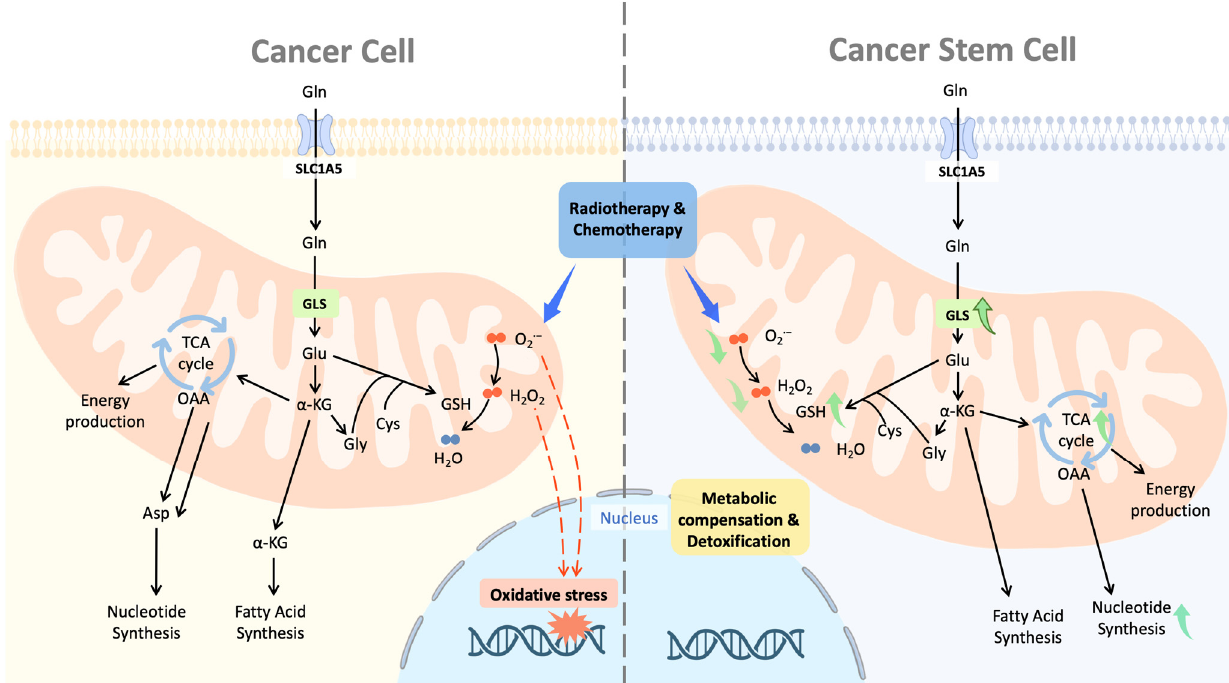
Figure 1. The metabolic compensation of CSCs. CSCs exhibit enhanced glutaminolysis as a result of the overexpression of glutaminase and the consumption of glutamine. This trait contributes to the metabolic compensation for chemotherapy by promoting the production of glutathione to scavenge free radicals and nucleotide biosynthesis to repair DNA damage. Both of these processes are necessary to compensate for the damage caused by chemotherapy. Additionally, glutathione has the ability to neutralize platinum medicines, thus lowering the drug concentration within cells. As a result of the metabolic compensation, CSC acquires the ability to resist therapy with conventional treat- ments.